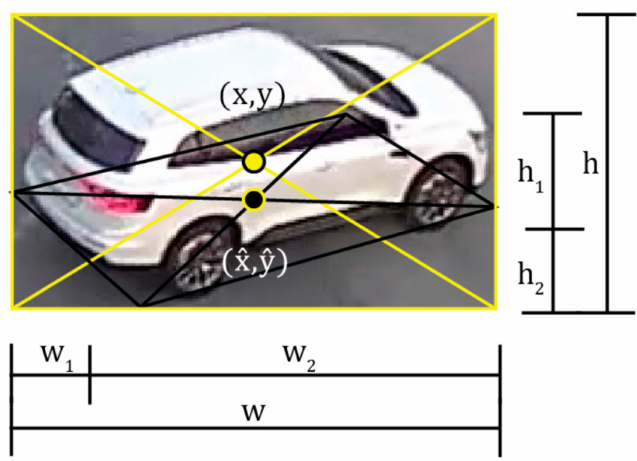
Figure 8. The relationship between the geometric parameters of the moving vehicle.